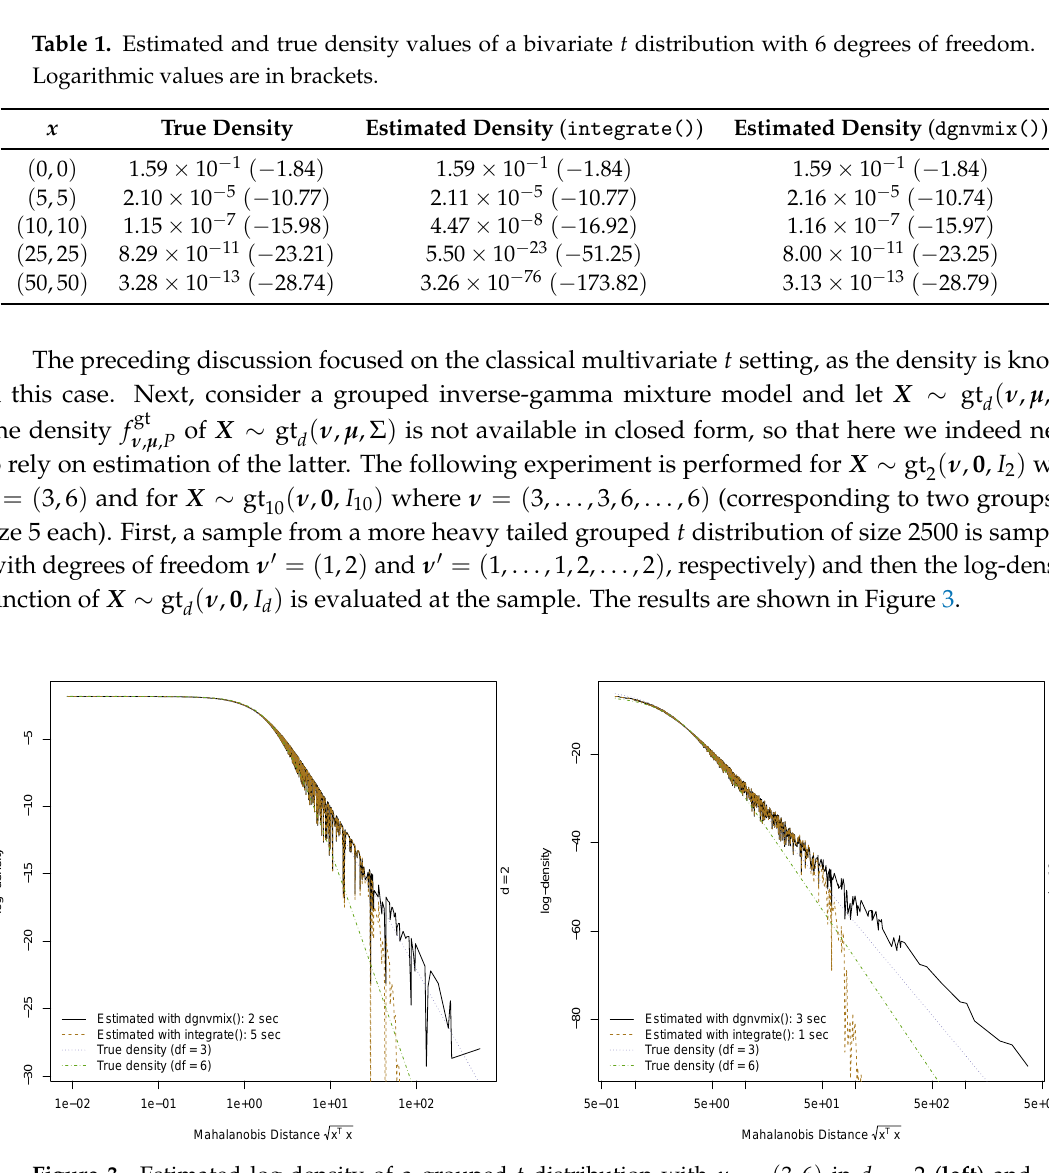
Figure 3. Estimated log-density of a grouped t distribution with ν = ( 3,6 ) in d = 2 ( left ) and ν = ( 3, . . . ,3,6, . . . ,6 ) in d = 10 ( right ). Estimation with dgnvmix() was carried out using a relative error tolerance of 0.01. The plot also shows the log-density function of t d ( 3, 0 , I d ) and t d ( 6, 0 , I d ) for